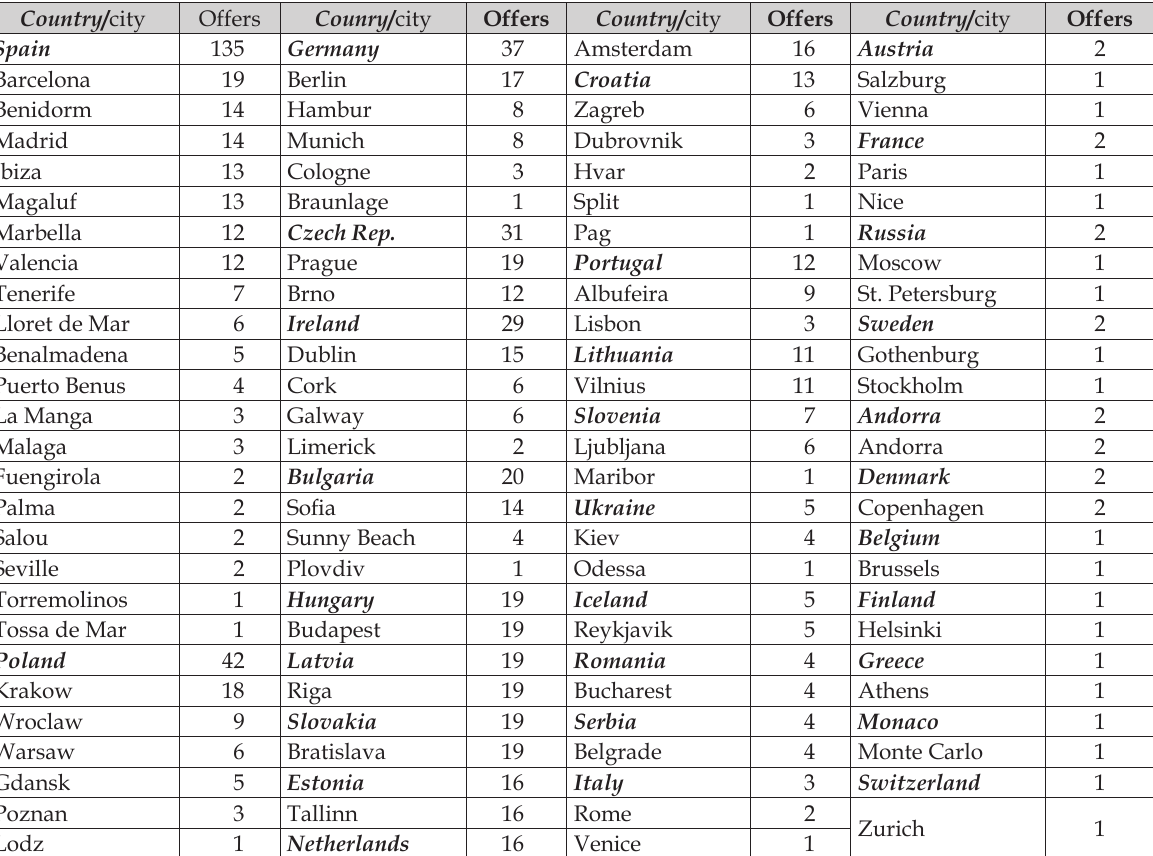
Table 2. Number of offers concerning particular stag party tourism centres based on the analysed offers. Country / city Offers Counry / city Offers Country / city Offers Country / city Offers Spain 135